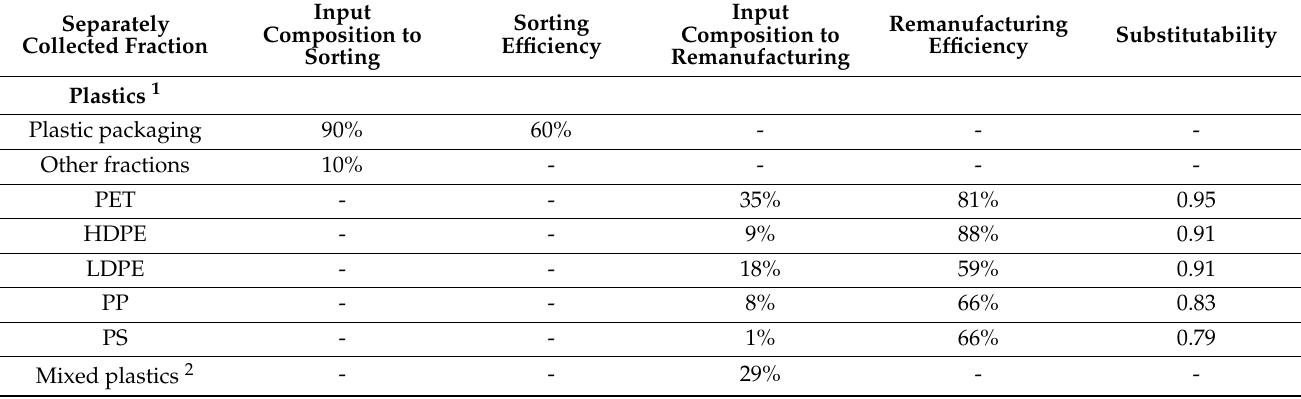
Table 1. Input parameters utilised together with quantified flow sheets to estimate the environmental burdens related to management of separately collected dry recyclable